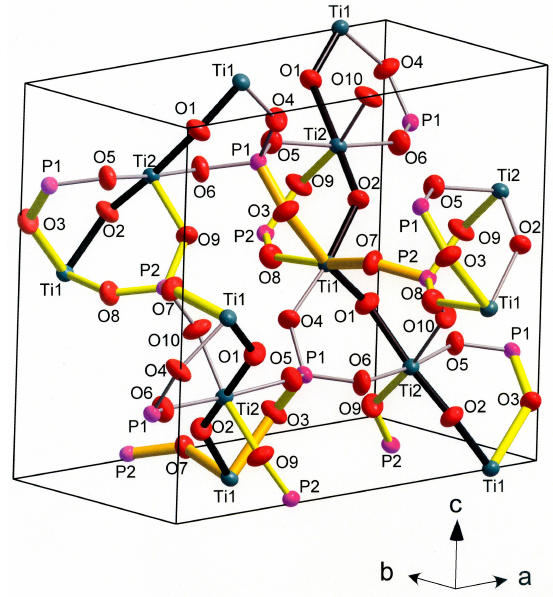
Figure 3. Structure of KT Р single crystals (ellipsoids of atomic displacements are drawn at the 50%